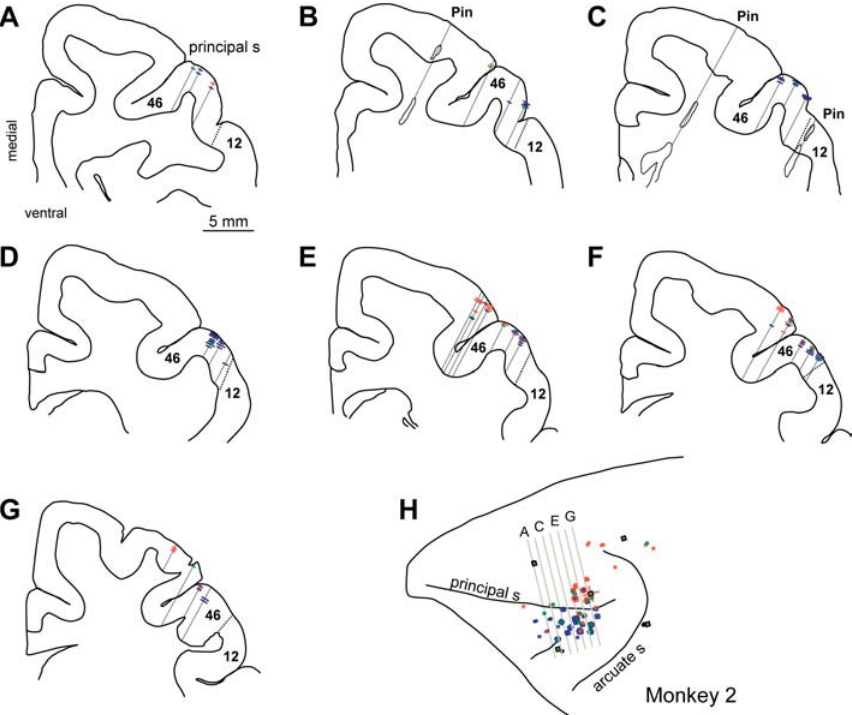
Figure 5. Section Reconstructions for Monkey 2 (A–G) Coronal sections taken at the planes indicated in the surface drawing (H). Dashed lines mark the borders between PFdl (area 46) and area 12. Solid lines show the tracks of the mark- ing pins (irregular outlines in sections [B] and [C]) and the estimated location of electrode penetrations. Colored hash marks show the estimated depth of neurons in each class, using the same color code as in Figures 3 and 4. Longer hash marks indicate simultaneous re- cordings of more than one neuron of the same class. (H) Lateral view of left PF depicting surface projections of spatially tuned neurons. Black circles show the locations of pin holes used for local- ization, and gray squares show their predicted locations. DOI: